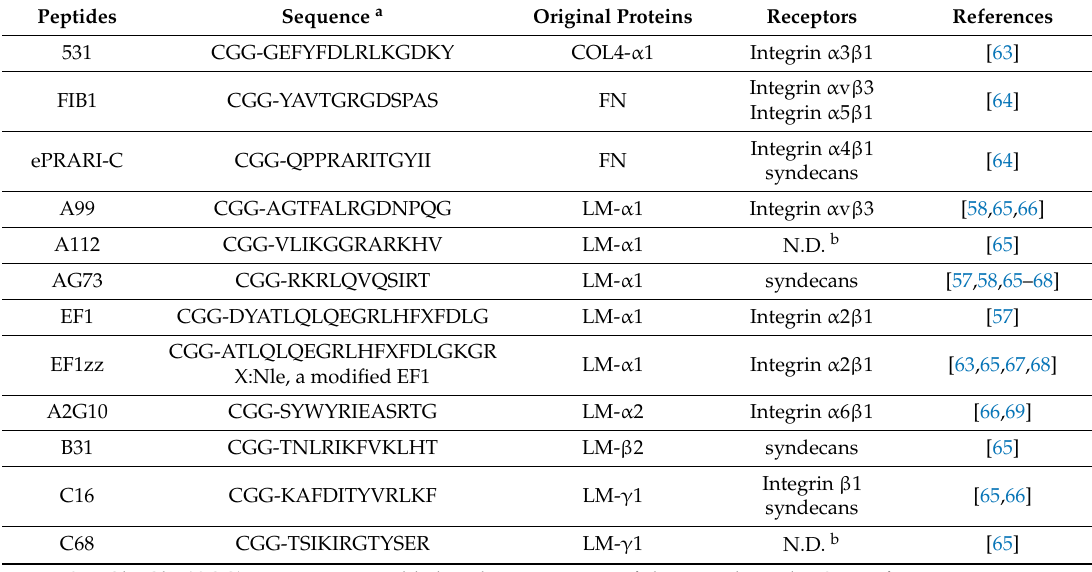
Table 1. List of cell adhesive peptides and their characters.